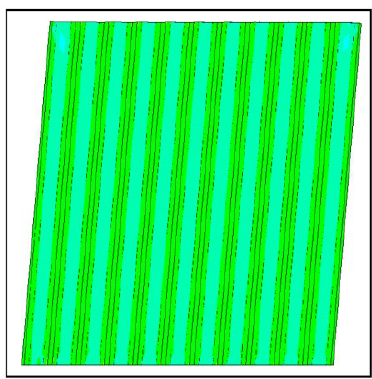
Figure 16. Heat affected zone (HAZ)